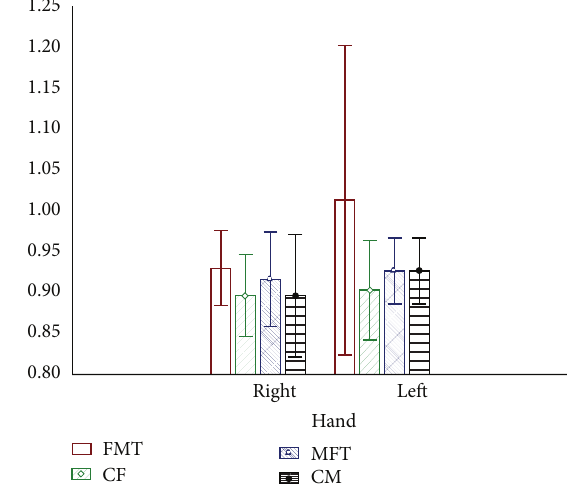
Figure 1: Finger length patterns in transsexuals and controls. FMT: female to male transsexuals. CF: control females. MFT: male to female transsexuals. CM: control males. right hand (0.920 versus 0.91) confirming lower androgeniza- tion effects in MFT during embryogenesis. FMT had the lowest left hand 2D : 4D compared to con- trol females and control males (0.926 versus 0.945 versus 0.945) confirming the hypothesis of androgenization of female brain during prenatal period in